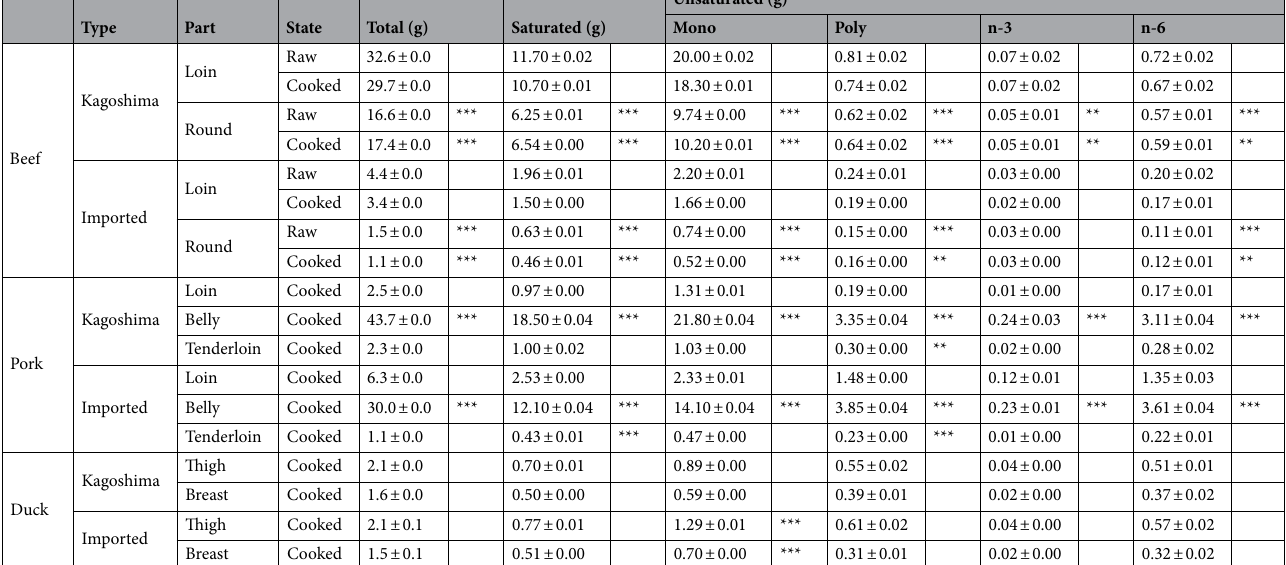
Table 2. Fatty acids in the 100-g fresh meat samples. *Indicates P < 0.05 vs. loin (beef and pork) or thigh (duck). **Indicates P < 0.01 vs. loin (beef and pork) or thigh (duck). ***Indicates P < 0.001 vs. loin (beef and pork) or thigh